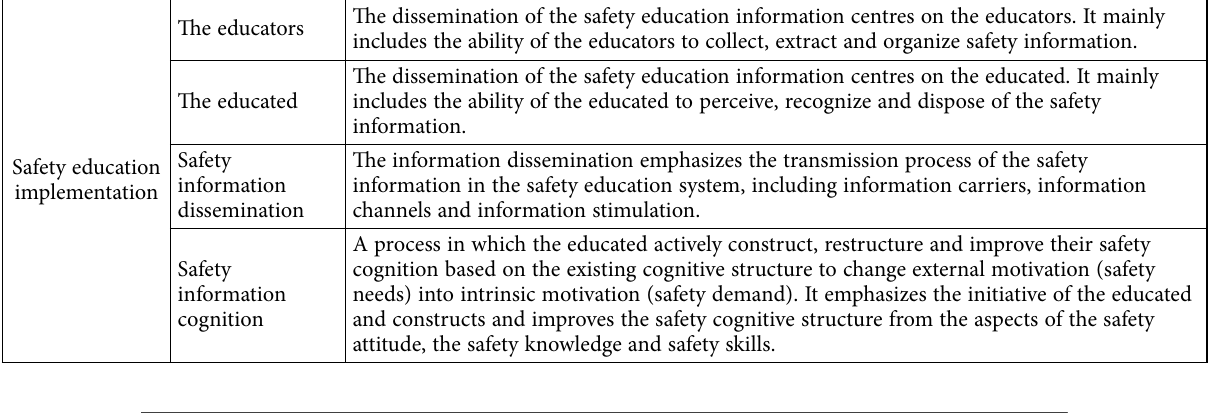
Table 5. Factors analysis of the safety education implementation from the perspective of the macro-system The educators